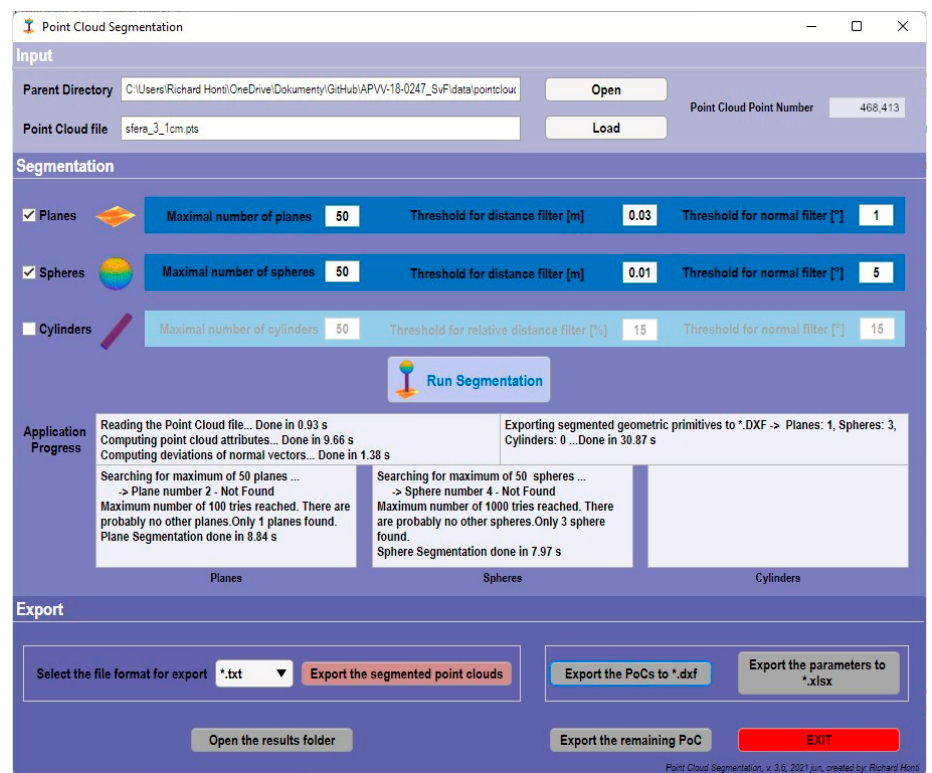
Figure 4. Dialog window of the PoCSegmentation application.